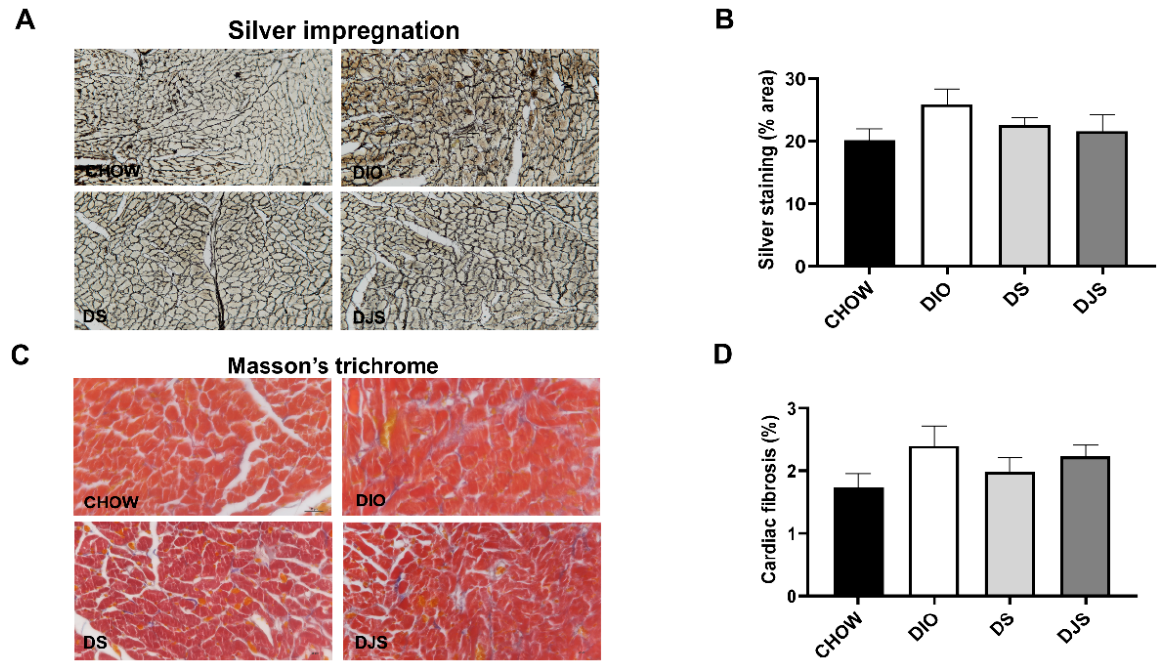
Figure 2. Assessment of cardiac fibrosis. ( A , B ) Representative pictures of silver impregnation stained cardiac sections and quantification of silver staining area. Magnification 20×. Scale bar 50 µm; ( C , D ) Representative pictures of Masson’s trichrome staining and quantification of fibrosis. Magnification 40×. Scale bar 25 µm. CHOW rats ( n = 8), fed with standard diet; DIO rats ( n = 9), fed with high-fat diet; DS ( n = 12), DIO rats supplemented with tart cherry seeds; DJS ( n = 9), DS rats supplemented with tart cherry juice. Data are mean ± SEM.